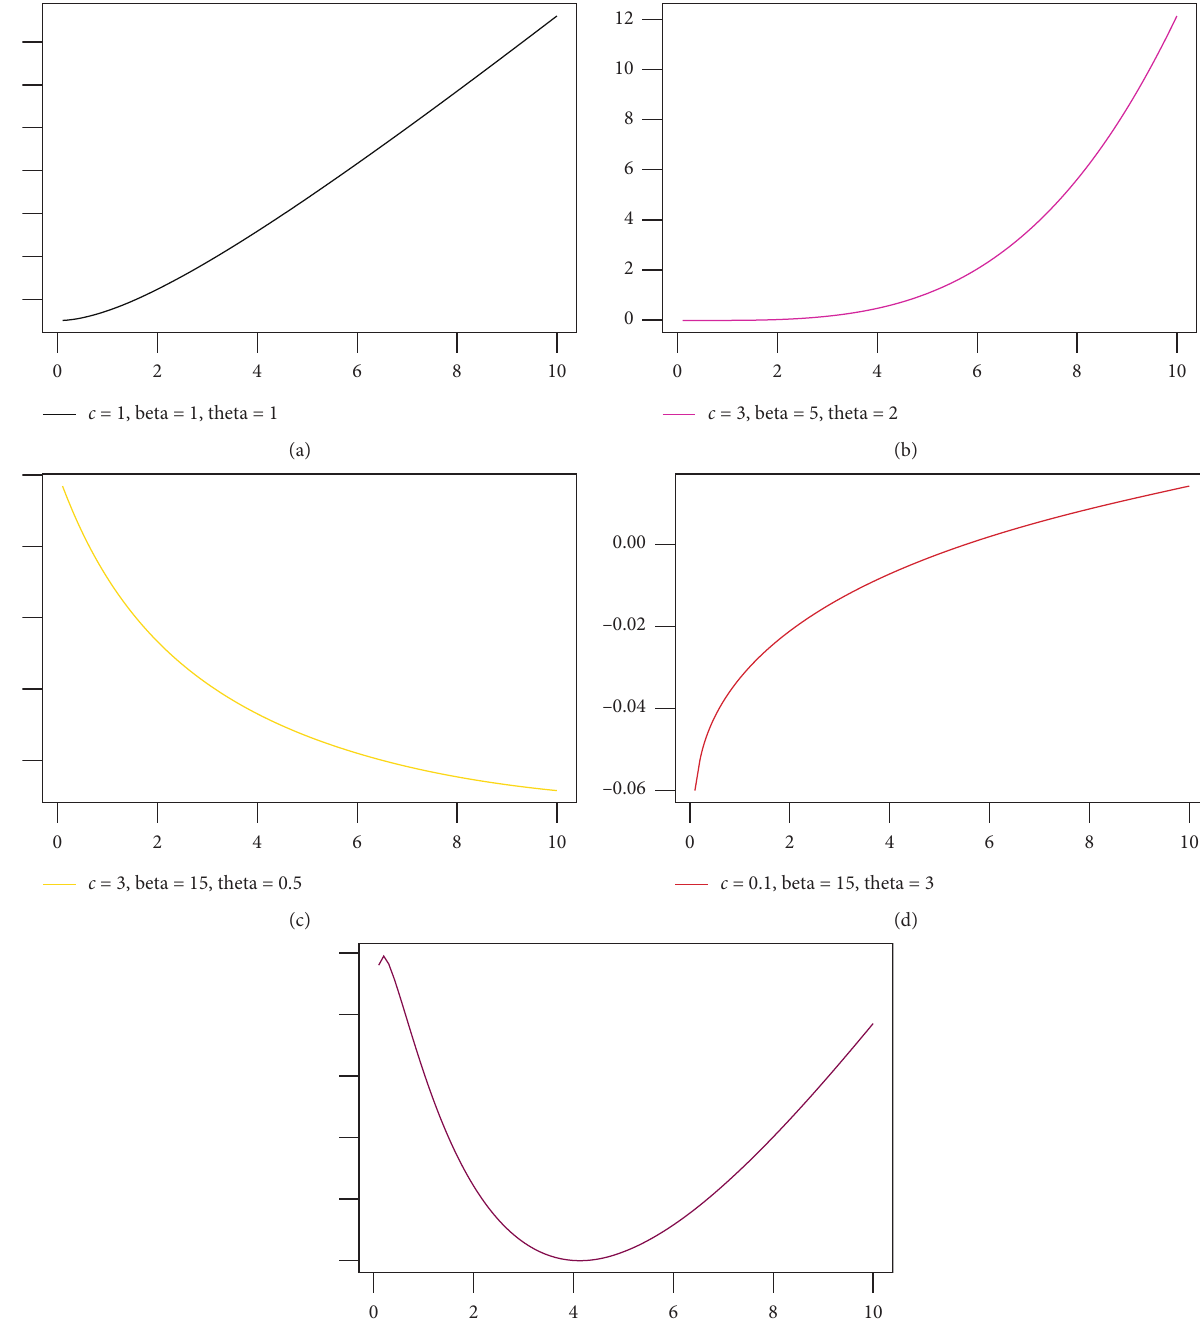
Figure 4: Hazard curves for generalized Weibull–Lindley (GWL) distribution for different parameter